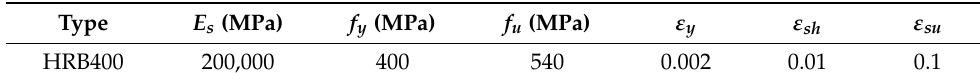
Table 3. Park constitutive parameters of pier fiber section steel.